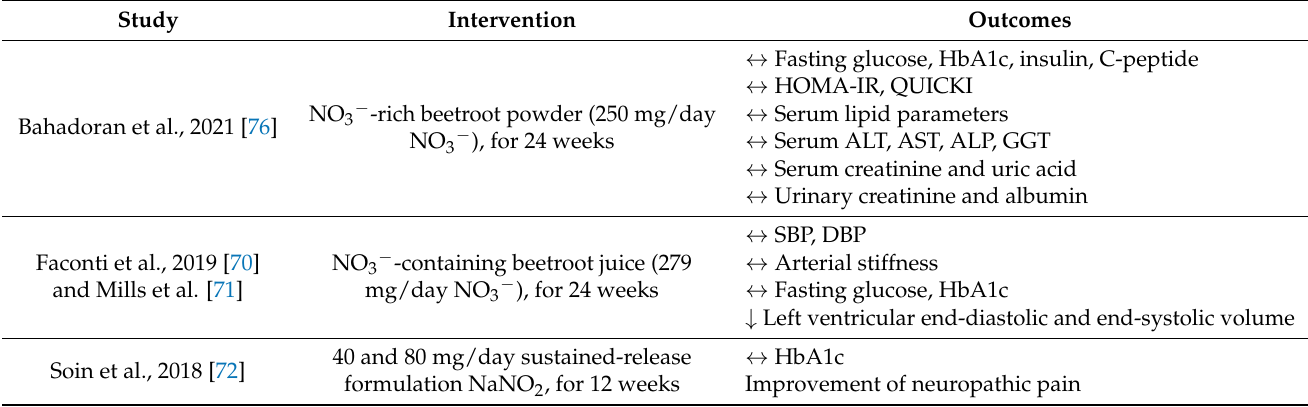
Table 2. Cardiometabolic effects of inorganic NO 3 − -NO 2 − in patients with type 2 diabetes mellitus: findings of clinical trials.